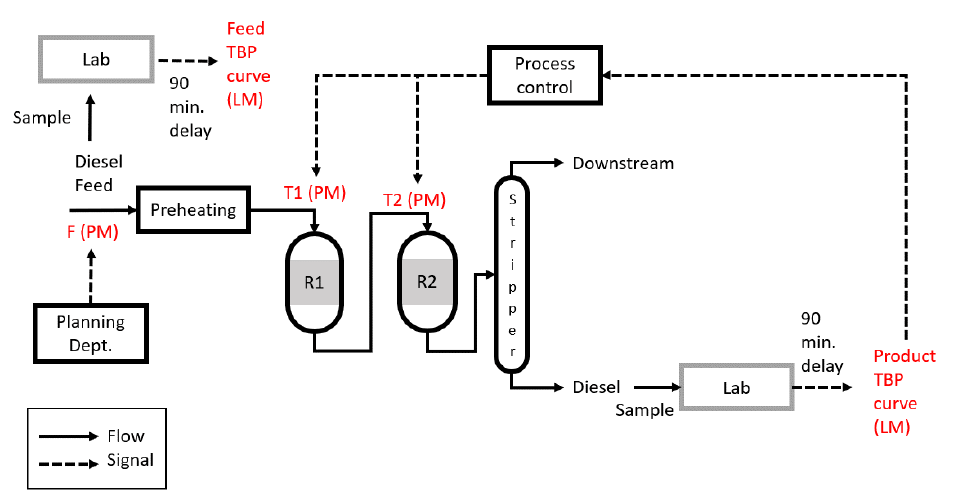
Figure 2. Hydrocracker unit flowchart with measurement locations and